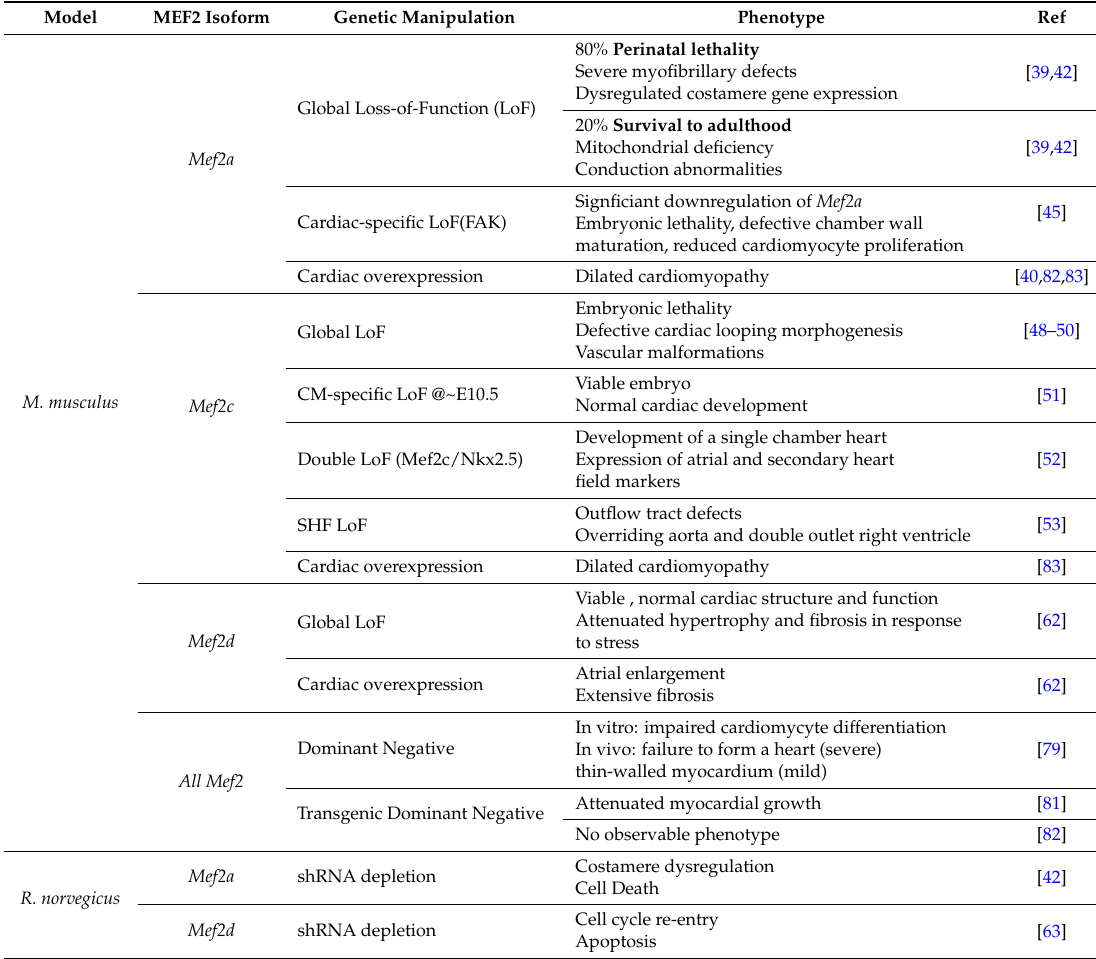
Summary of cardiac-related phenotypes of MEF2 family transcription factor family misexpression in mammalian model systems (four chambered